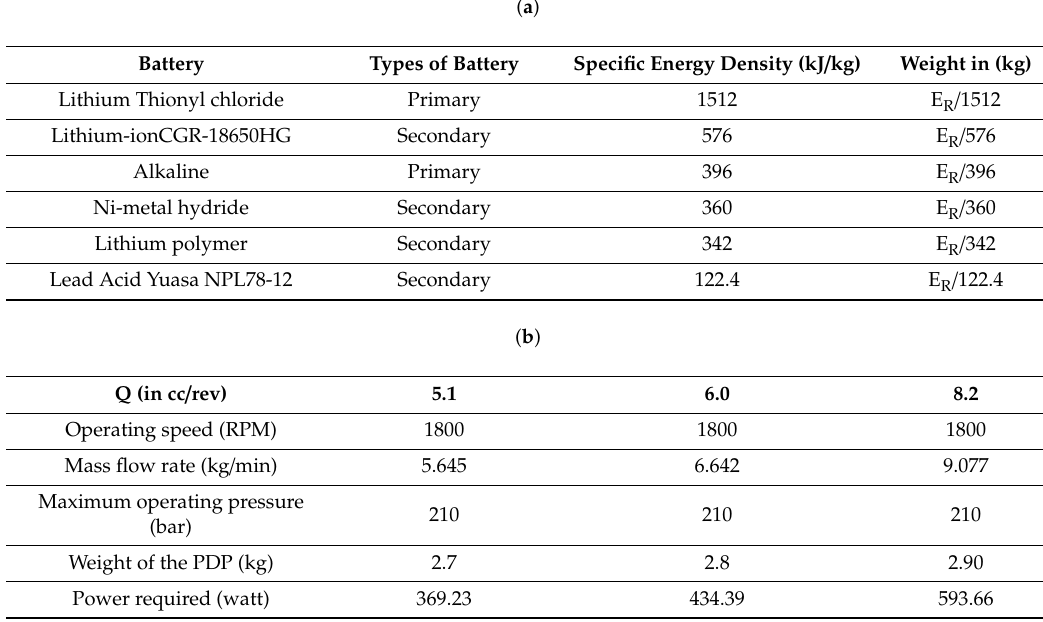
Table A1. ( a ) List of options for di ff erent specific energy density and mass of battery for a specific energy capacity (E R ) adapted from Wang et al. [33] and Gri ffi ths et al. [34] ( b ) Detailed specifications for di ff erent options of the